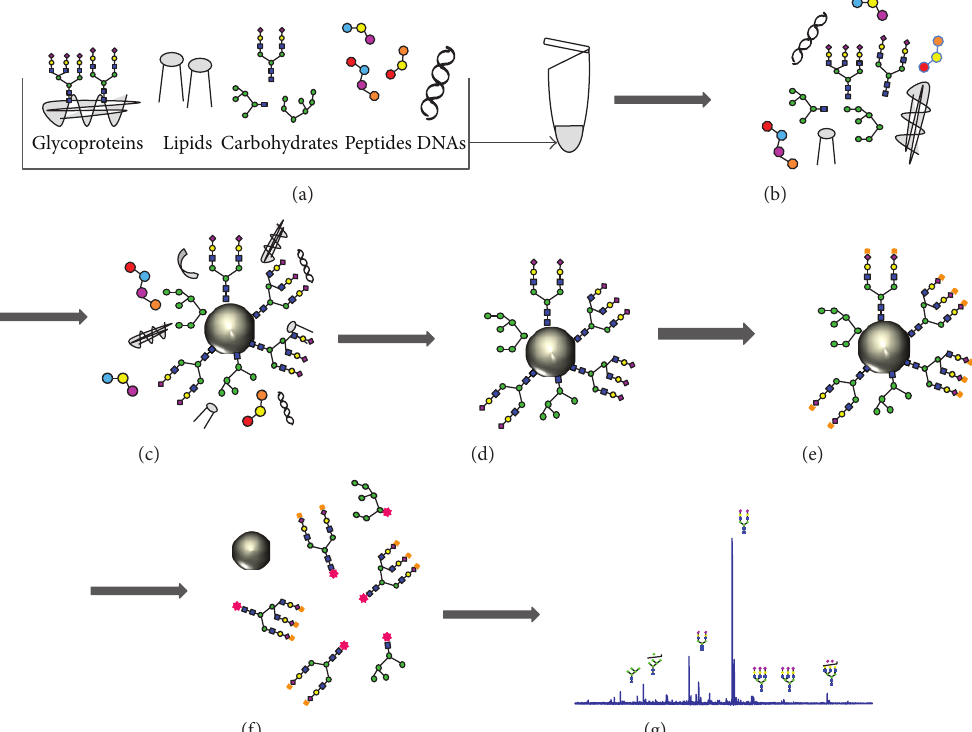
Figure 1: General protocol for the integrated glycoblotting technique and workflow for glycoblotting-based high-throughput clinical glycan analysis. Serum samples of 10 𝜇 L (a) were applied to the “Sweet Blot” automated machine for glycoblotting. After enzymatic cleaving from serum protein, the total serum N -glycans released in the digest mixture (b) were directly mixed with BlotGlyco H beads (Sumitomo Bakelite, Co., Tokyo, Japan) to capture N -glycans (c). After the beads had been separated from other molecules by washing (d), sialic acid was methyl esterified (e). The processed N -glycans were then labeled with benzyloxyamine (BOA) and released from the BlotGlyco H beads (f). Mass spectra of BOA-labeled N -glycans were acquired with an Ultraflex III instrument (Bruker Daltonics, Germany)